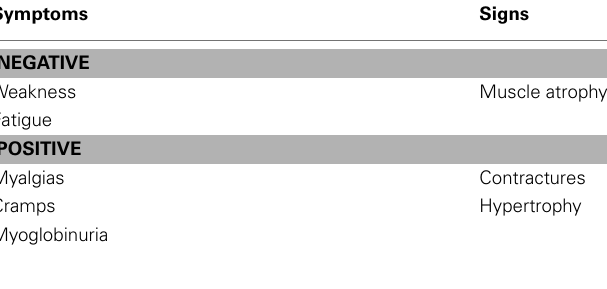
Table 5 | Acquired causes of